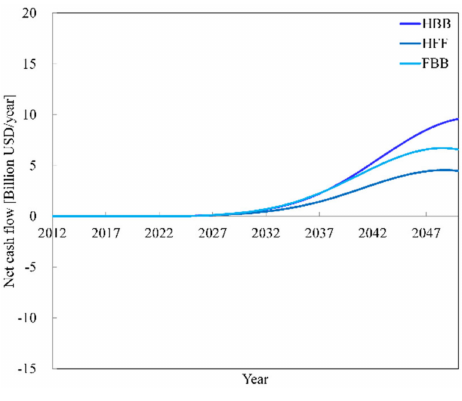
Figure 12. Net cash